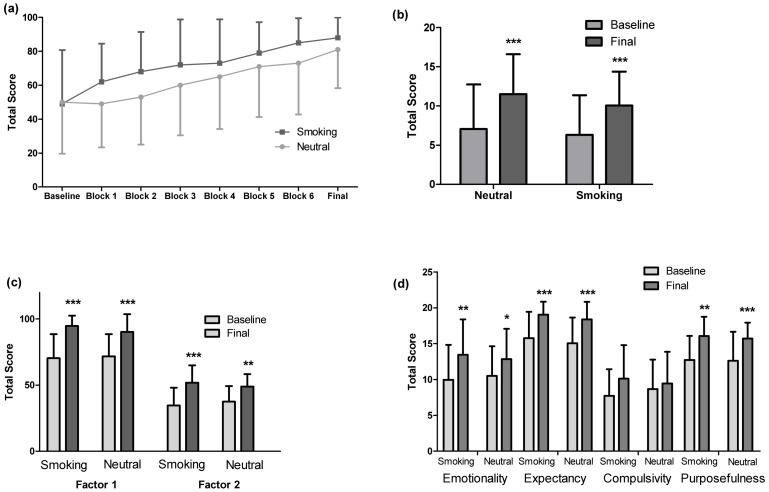
Craving measures assessed comparing smoking and neutral cue conditions.(a) Visual analog scale measurements of craving for a cigarette assessed every fifteen minutes during cue-presentation (Blocks 1–4) and every 15 minutes following the completion of the paradigm (Blocks 5–6). There was a main effect of cue type (Repeated Measures Analysis of Variance (RM-ANOVA, F(1,17) = 6.935, p<0.05) and time (RM-ANOVA, F(7,119) = 18.098, p<0.005) on craving for a cigarette. (b) Withdrawal symptoms as rated by the Minnesota Nicotine Withdrawal Scale at baseline (prior to cue presentation) and at the end of the scan. There was a main effect of time on withdrawal symptoms (RM-ANOVA, F(1,17) = 23.996, p<0.001) (c) Cigarette craving as measured by the Questionnaire of Smoking Urges Factor 1 (urge to smoke for pleasure effects of smoking) and Factor 2 (urge to smoke for relief of negative effect of withdrawal) at baseline and at the end of the scan. There was a main effect of time on the urge to smoke for pleasurable effects (RM-ANOVA, QSU Factor 1 F(1,17) = 53.866, p<0.001) and on the urge to smoke for relief of negative symptoms (RM-ANOVA, QSU Factor 2, F(1,17) = 27.591, p <0.001) (d) Cigarette craving measured by the Tobacco Craving Questionnaire factors 1 (Emotionality), 2 (Expectancy), 3 (Compulsivity) and 4 (Purposefulness) at baseline and at the end of the scan. There was a main effect of time on the urge to smoke for relief of negative withdrawal effects (RM-ANOVA, TCQ 1/emotionality F(1,17) = 11.907, p<0.005), urge to smoke for pleasurable effects (RM-ANOVA, TCQ 2/expectancy F(1,17) = 25.510, p<0.001) and intention to smoke (RM-ANOVA, TCQ 4/purposefulness F(1,17) = 14.336, p<0.005). * p<0.05, ** p<0.01, *** p<0.005